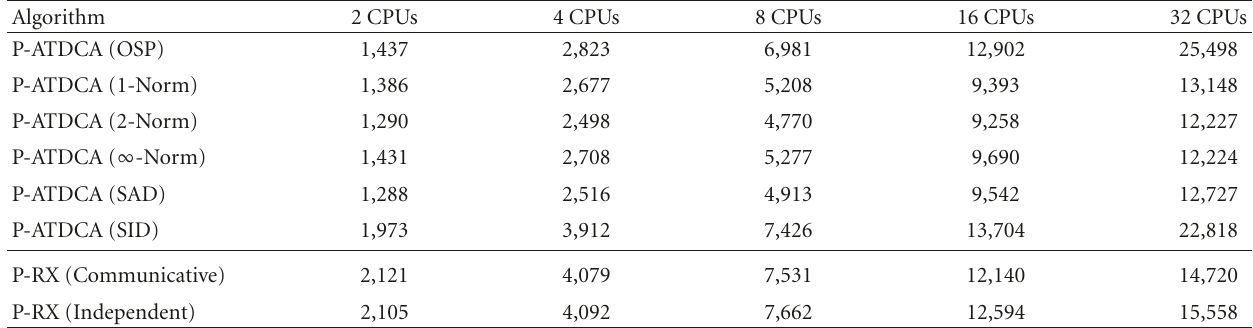
Table 6: Speedups for the P-ATDCA algorithm (using di ff erent distance measures) and P-RX using di ff erent numbers of CPUs on the Thunderhead Beowulf